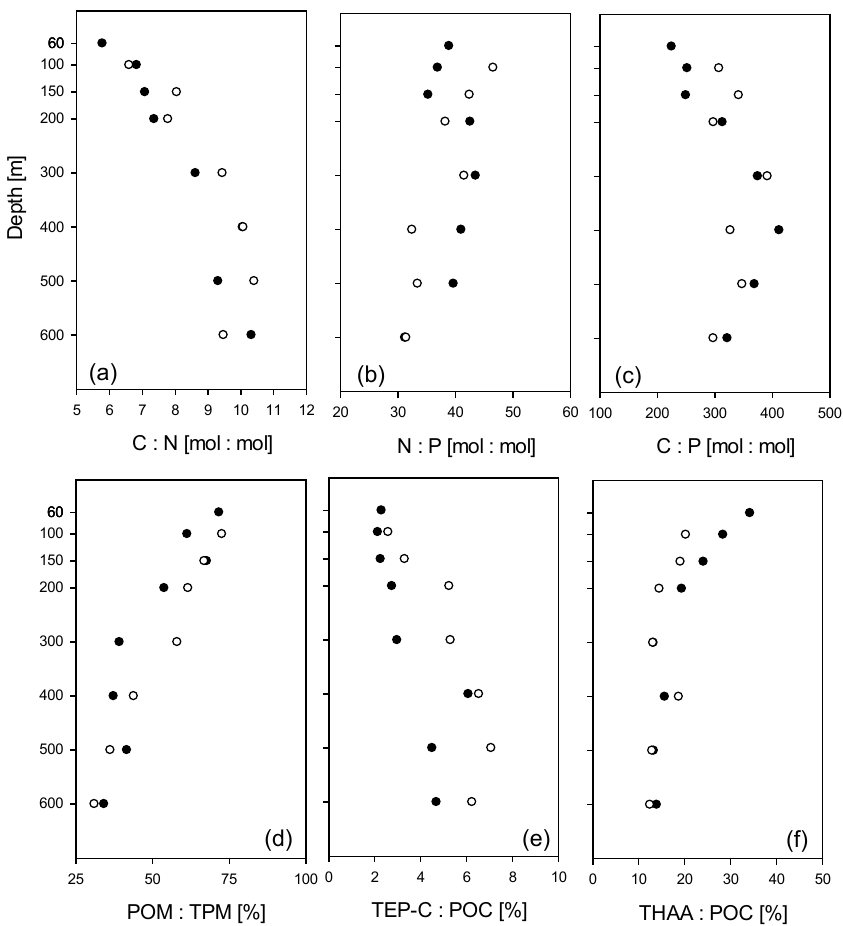
Figure 5. Changes in organic matter composition of particles sinking through the OMZ during the deployment of two STDT in the ETNA. Solid symbols are used for deployment no. 1 and open symbols for deployment no.